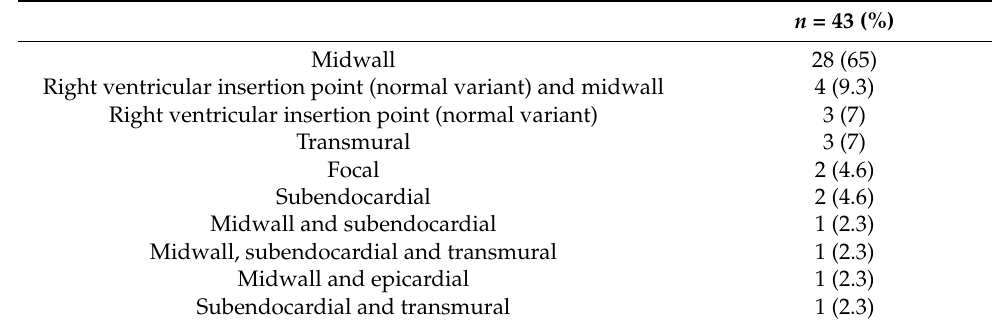
Table 3. Patterns of late gadolinium enhancement in IDCM